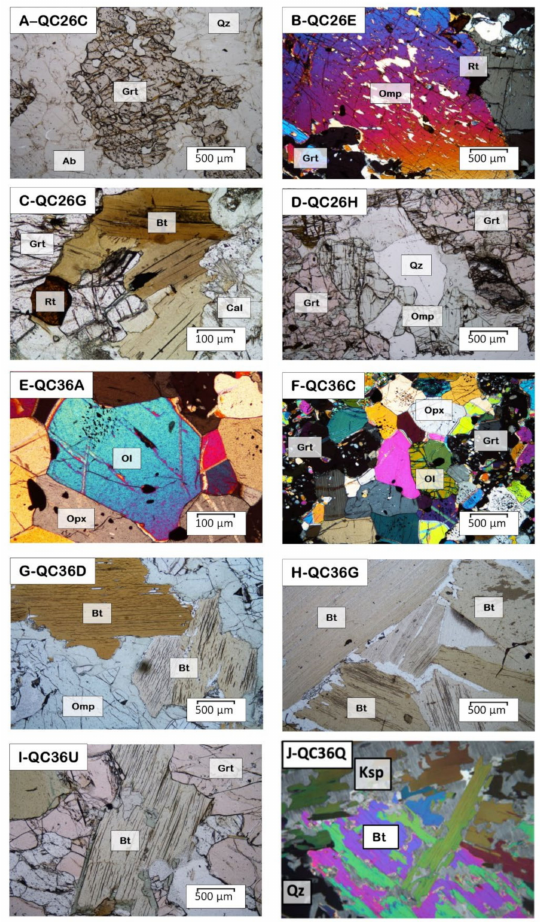
Figure 2. Photomicrographs showing key features of samples. ( A – D )—Årsheimneset; ( E – J )—Svartberget. ( A ) QC26C gneiss—PPL; ( B ) QC26E eclogite—XPL; ( C ) QC26G garnet-phlogopite